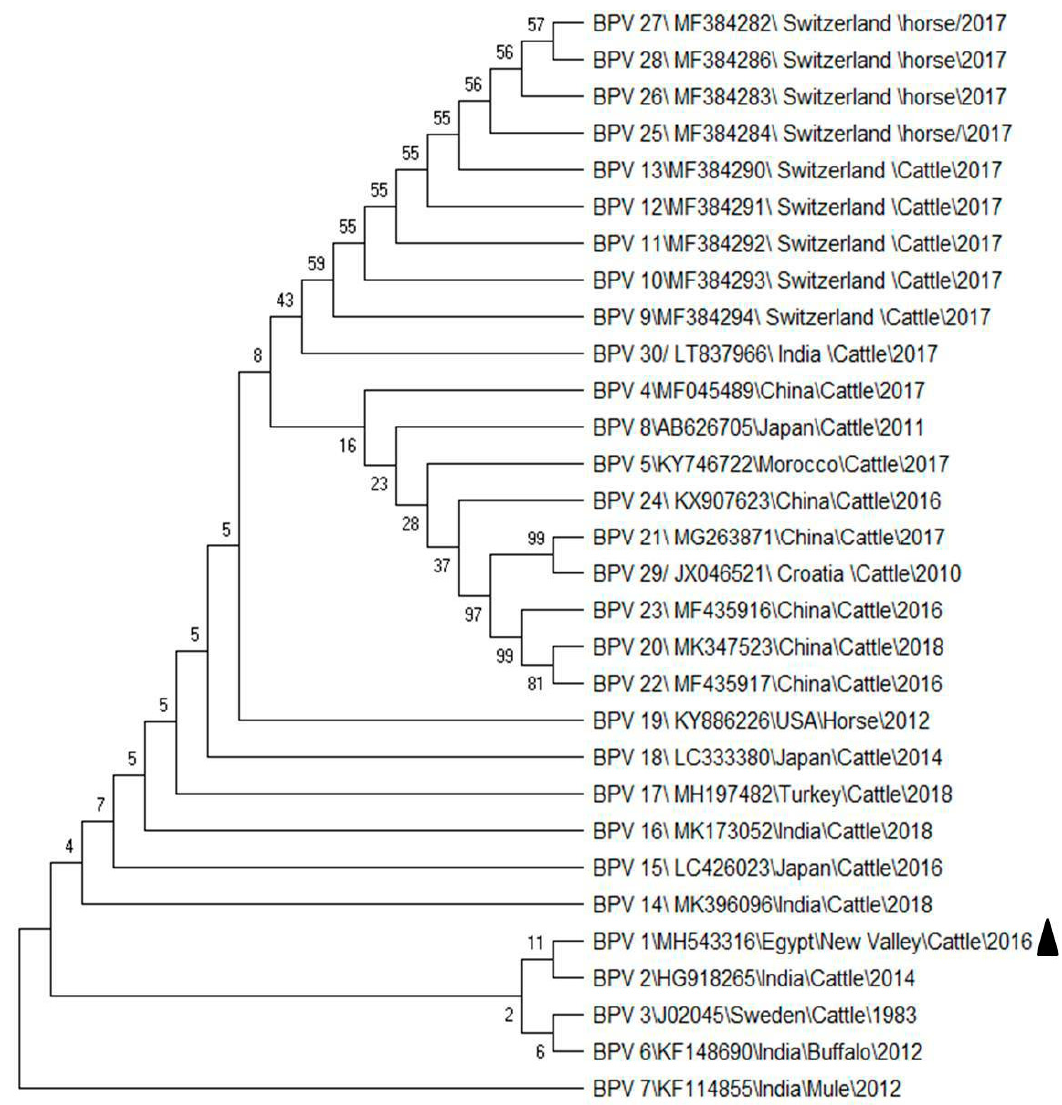
Figure 2. Phylogenetic tree of our bovine papillomavirus type-1 (BPV-1) from cattle with others BPVs that were taken from the GeneBank database based on L1 gene sequences. Numbers at the internal nodes represent the bootstrap probabilities (1000 replicates).